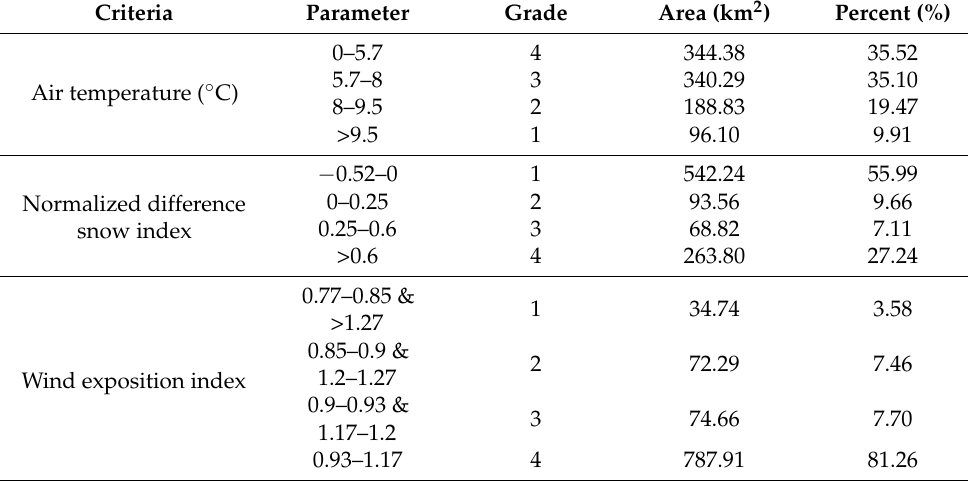
Table 8. Assessment of climatic